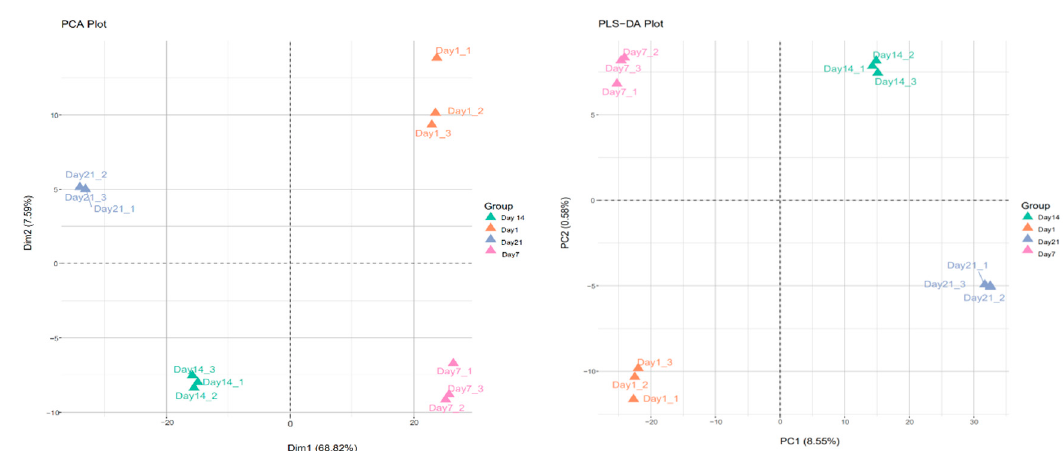
Figure 4. PCA and PLS-DA analyses on the differentially expressed proteins in Lpb. plantarum NMGL2 in fermented milk stored at low temperature (4 °C) for 1, 7, 14, and 21 days. (Dim1: Principal component 1. Dim2: Orthogonal component 1. PC1: Measurement of fit. PC2: Measurement of prediction).